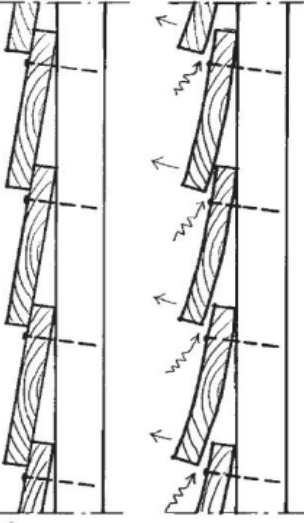
Figure 1. A traditional environmentally friendly construction technique in Norway, reprinted from [4] .